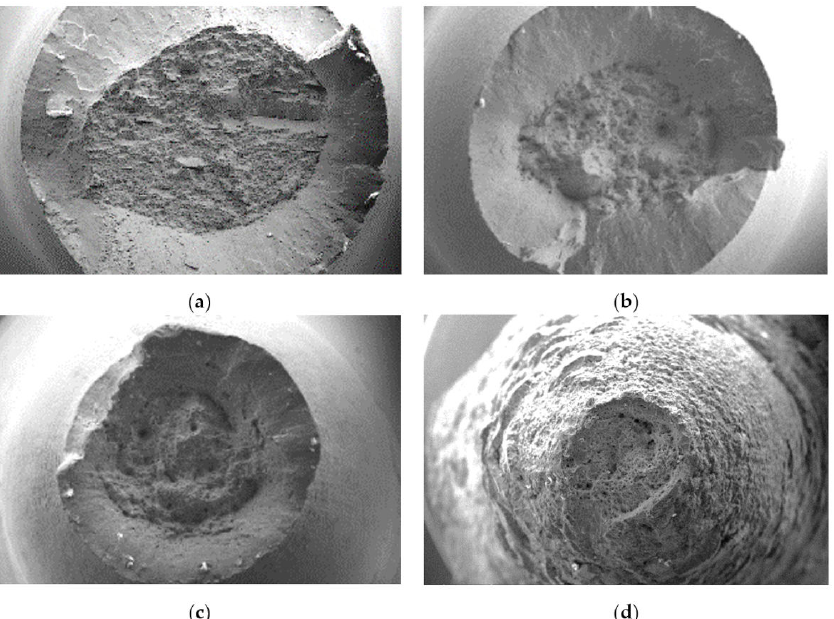
Figure 12. Microfractography of the tensile separating fractures of Armstal 550 specimens tested at temperatures of ( a ) 298 K, ( b ) 573 K, ( c ) 773 K, ( d ) 973 K.